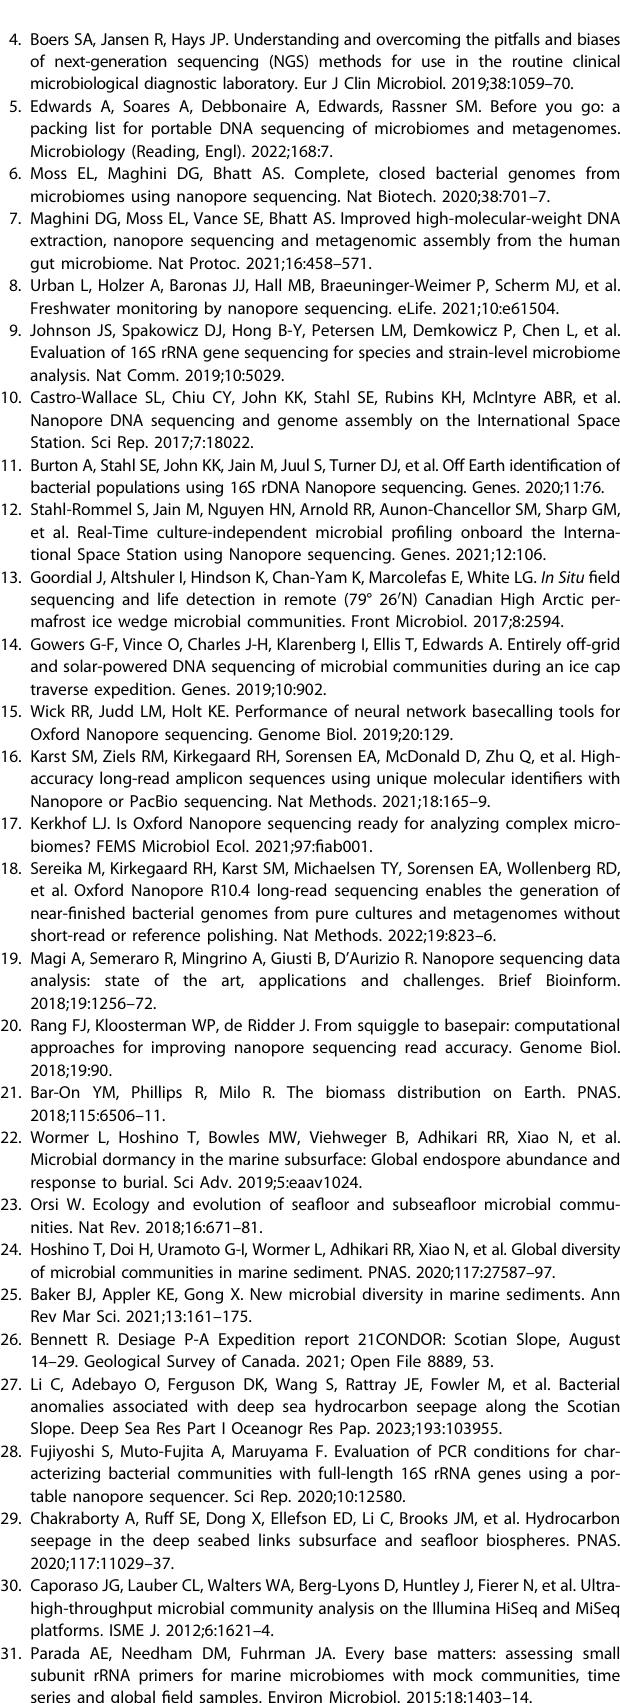
table nanopore sequencer. Sci Rep. 2020;10:12580. 29. Chakraborty A, Ruff SE, Dong X, Ellefson ED, Li C, Brooks JM, et al. Hydrocarbon seepage in the deep seabed links subsurface and sea fl oor biospheres. PNAS. 2020;117:11029 –